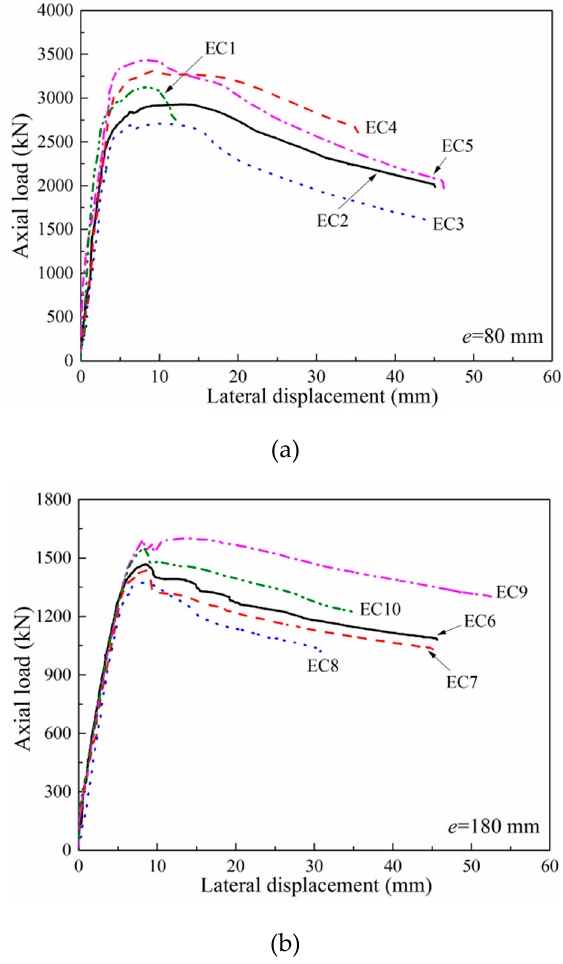
Figure 5. Load-displacement curves of the columns ( a ) nominal eccentricity ( e = 80 mm); ( b ) nominal eccentricity ( e = 180